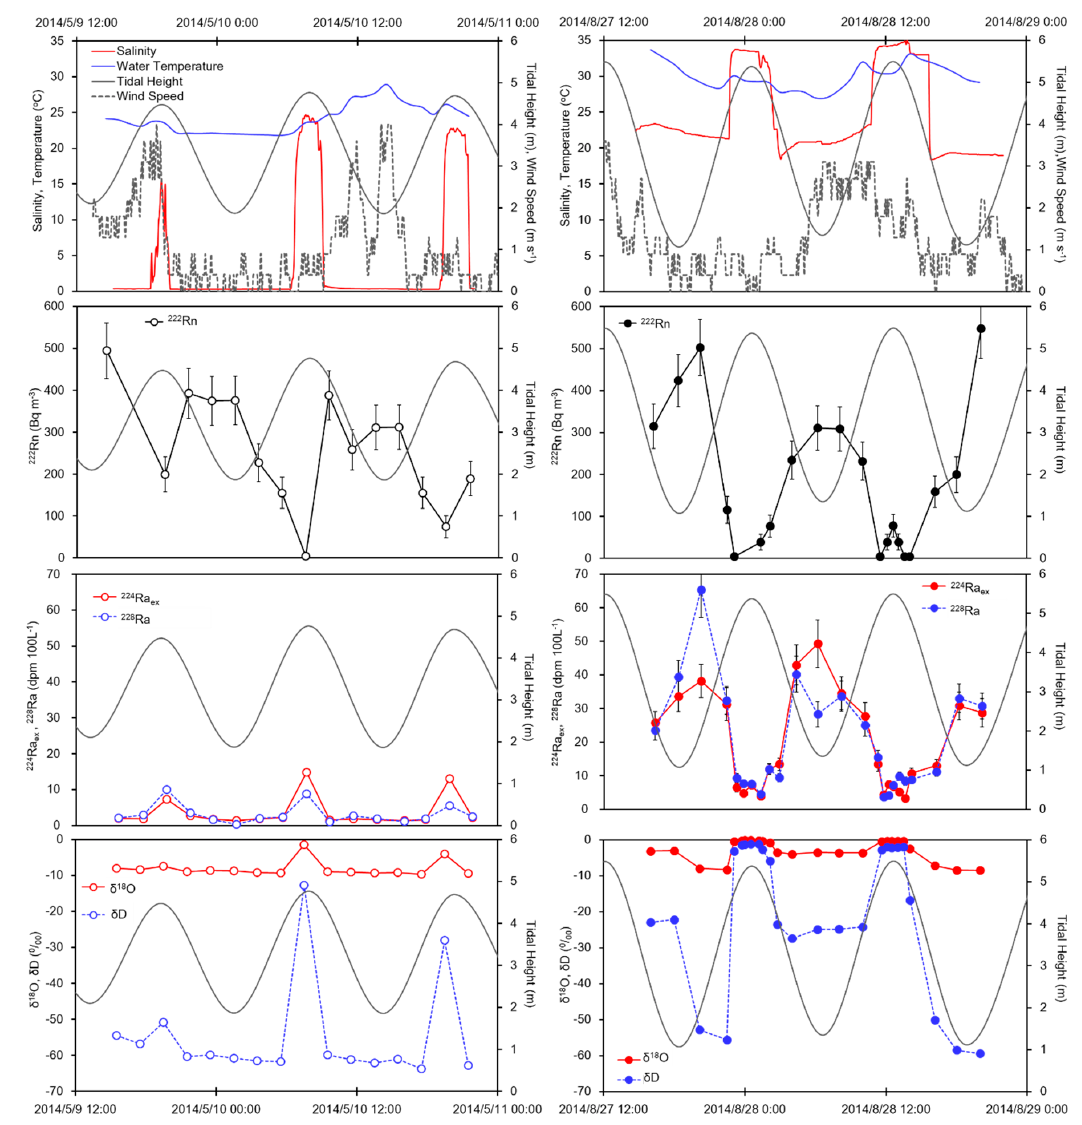
Figure 2. The diagrams display the temporal variations of salinity, activities of 222 Rn, 224 Ra ex and 228 Ra, δ 18 O, and δ D in coastal water collected from the Gaomei Wetland (left: Dry season, 9~10 May 2014; right: Wet season, 27~28 August 2014) with tidal height and wind speed. All of these revealed variations with tidal fluctuations.